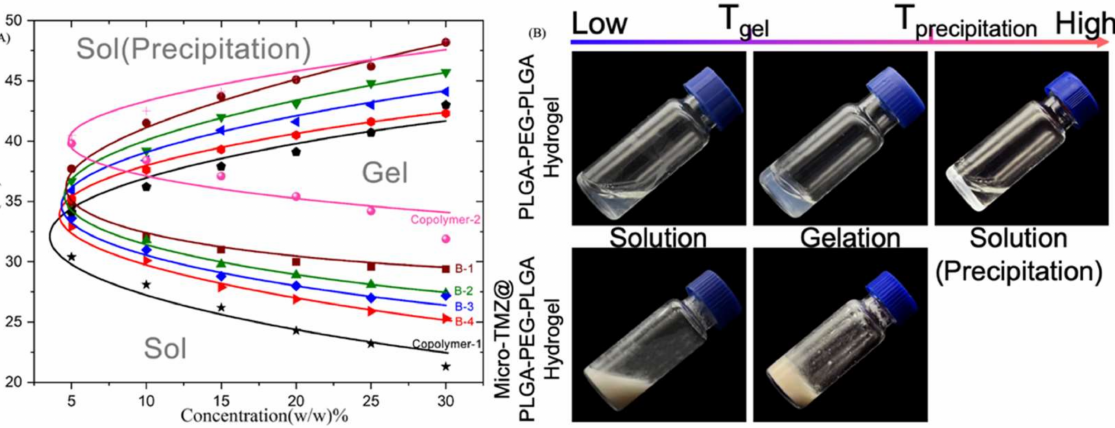
Figure 1. Macro appearance of PLGA–PEG–PLGA thermosensitive hydrogel and preparations. ( A ) Phase diagram of Copolymer–1, Copolymer–2 and blending samples B–1, B–2, B–3, B–4 using Tube–Reverting Method. ( B ) The macro appearance of PLGA–PEG–PLGA hydrogel and micro- TMZ@PLGA–PEG–PLGA hydrogel under 3 temperature stages (below T gel , between T gel and T precipitation , and beyond T precipitation